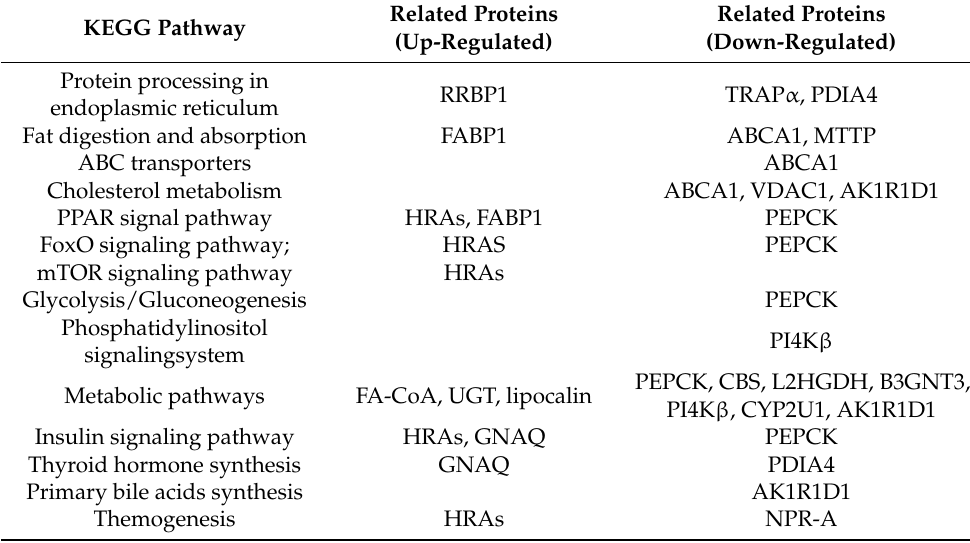
Table 7. Selected KEGG pathway analysis of differentially expressed proteins related to metabolic fatty liver. Related KEGG Pathway